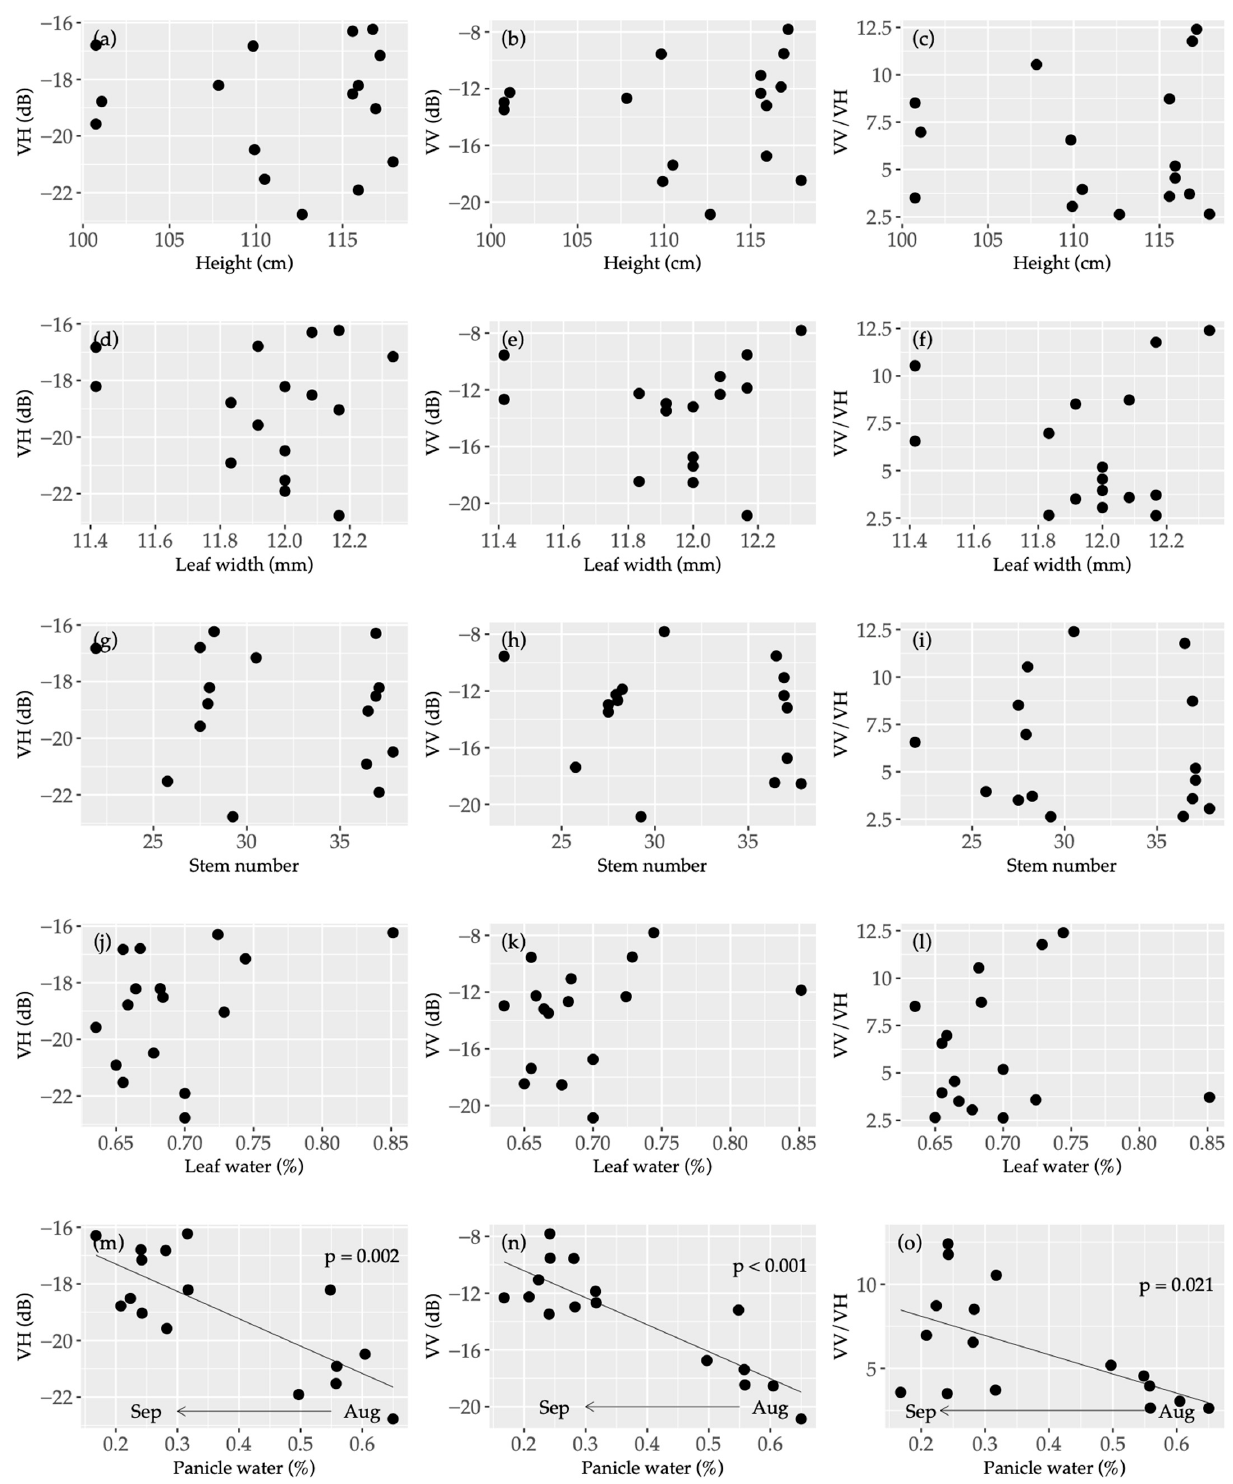
Figure 9. Scatter plots between biophysical parameters during reproduction and ripening periods and microwave backscatters taken in orb 46. Plant height (cm), maximum leaf width (mm), stem number, and water content in leaves and panicles (%) are field measurement data. The leftmost column depicts VH, the center shows VV, and the rightmost presents VV/VH. ( a – c ) plant height, ( d – f ) maximum leaf width, ( g – i ) stem number, ( j – l ) leaf water content, and ( m – o ) panicle water content